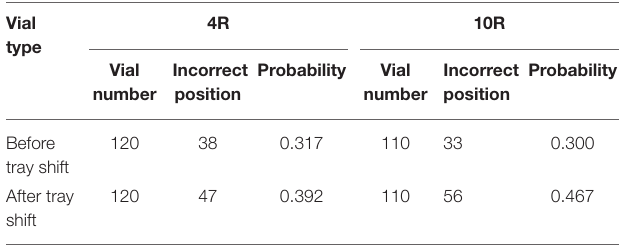
TABLE 3 | Observed point probability of incorrect positioning of the thermocouple in the vials. Vial